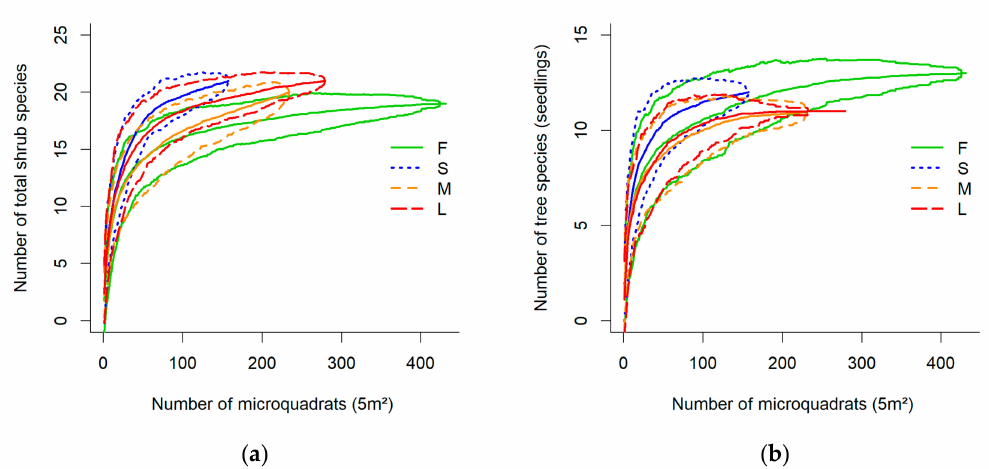
Figure 6. Species accumulation curves from four gap / forest environments (forest (F) understory, small (S) gaps, medium (M) gaps, large (L) gaps) for shrub ( a ) and tree seedling ( b ) species. Envelopes show boot-strapped 95% confidence